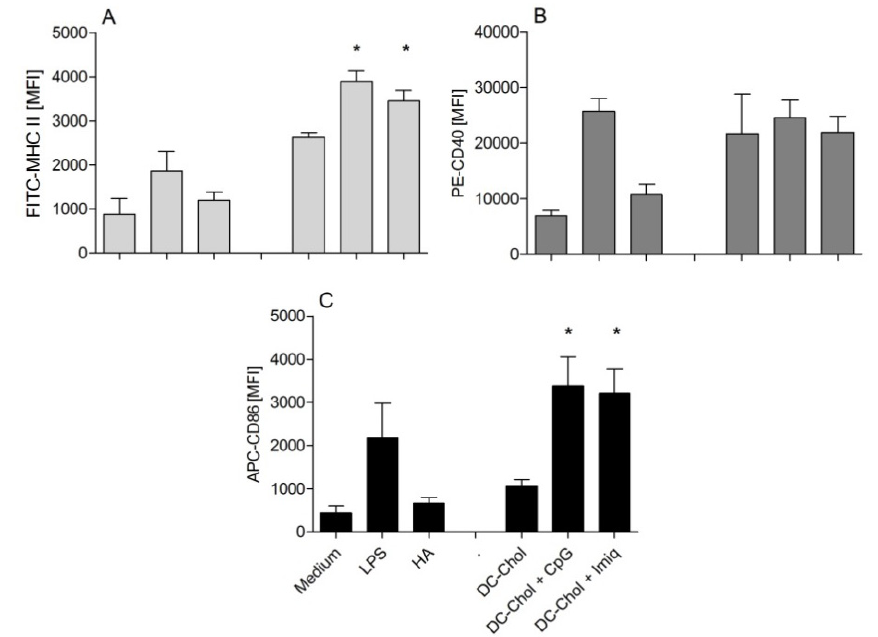
Figure 4. Upregulation of DC maturation markers induced by free HA versus HA mixed with liposomes: MHCII ( A ); CD40 ( B ); and CD86 ( C ). The values are expressed as percentage of mean fluorescence intensity (compared to a 100 ng/mL LPS control group, arbitrarily set as 100%). Error bars represent SEM ( n = 3). Significant differences between the formulations and the DC-Chol:DPPC group are indicated with * ( p < 0.05). See Supplementary Material, Figure S2, for representative side scatter-forward scatter dot